Question: Give a one-sentence summary of this figure.
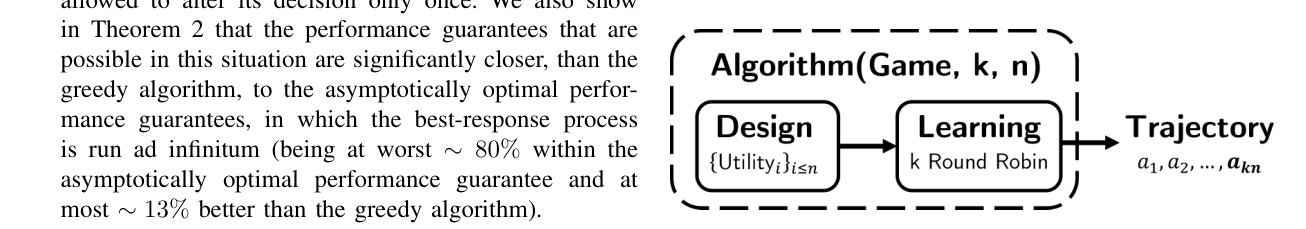
Answer: If a given multi-agent scenario with n agents is modeled as a game, the construction of distributed algorithms can be decoupled into two domains: the design of local objectives (utilities) and the design of the learning dynamics. In this paper, we fix the dynamics to the classical round-robin best response and study the effects of the utility design on the resulting efficiency bounds on the trajectory. Moreover, we characterize the efficiency guarantee as the number iterations κ that the Algorithm is run for increases.